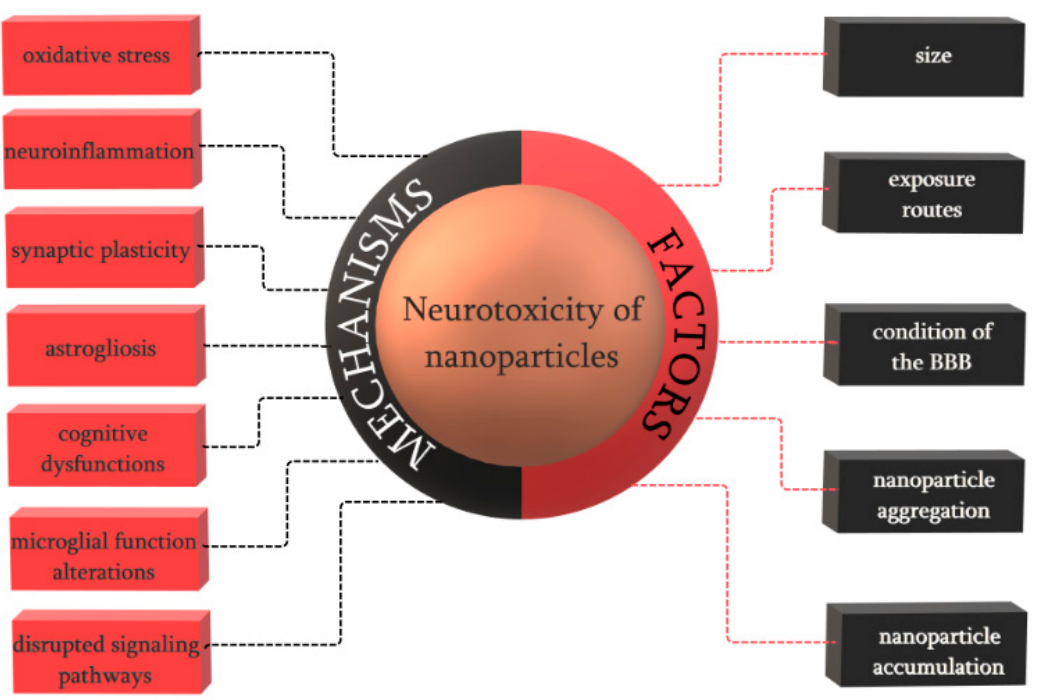
Figure 2. The main mechanisms and factors of neurotoxicity induced by nanoparticles.